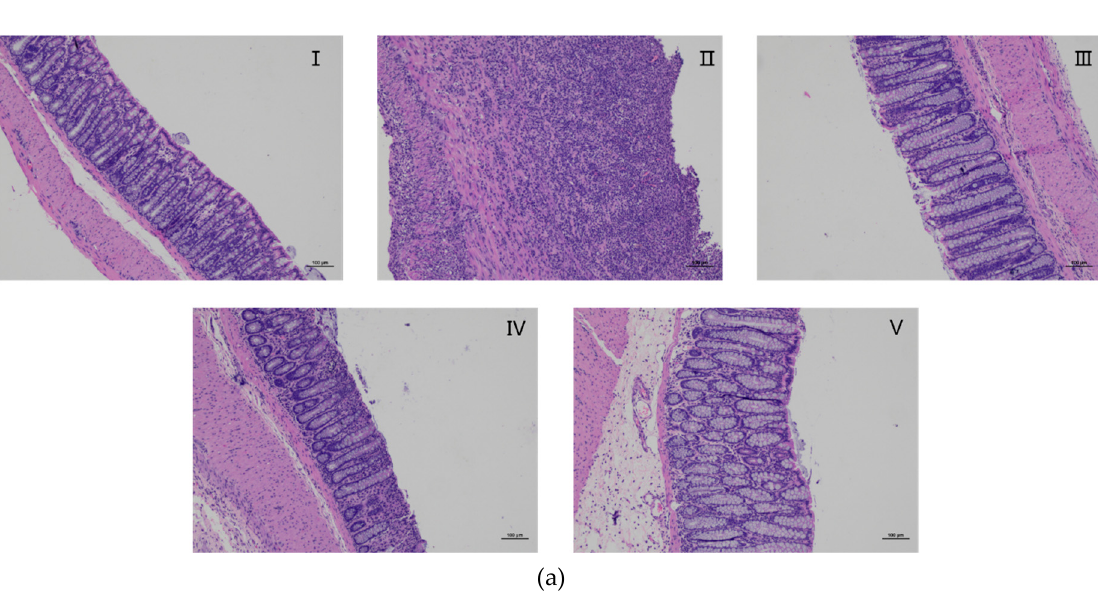
Figure 5. Effects of AZ-SFE (30 and 60 mg/kg) and mesalazine (400 mg/kg) on ( a ) body weight change, ( b ) disease activity index, ( c ) length of colons, and ( d ) macroscopic score of colons in TNBS-induced colitis rat model. Data are presented as mean ± SD of 6 rats per group. * p < 0.05, and ** p < 0.01 versus TNBS